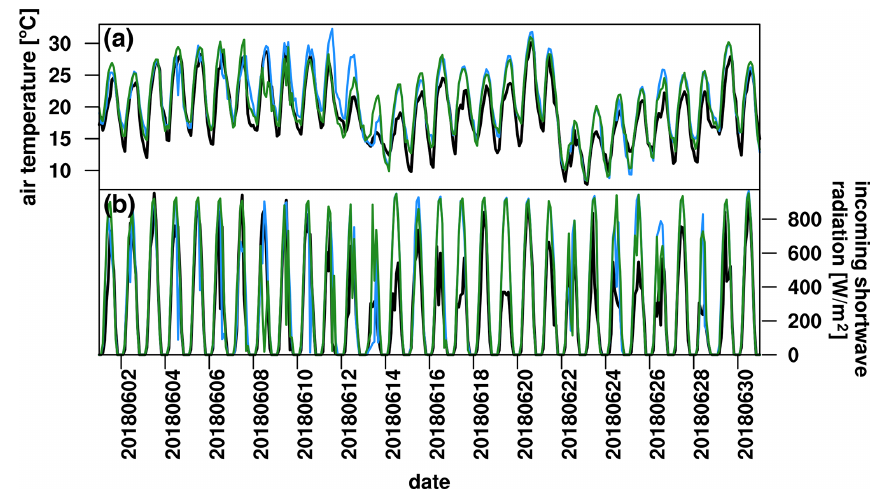
Figure 5. Time series of (a) 2m air temperature and (b) incoming shortwave radiation at the station in Nuremberg from 1 June to 1 July 2018. Observational, WRF_NO_NUDGE and WRF_NUDGE data are shown in black, blue and green,